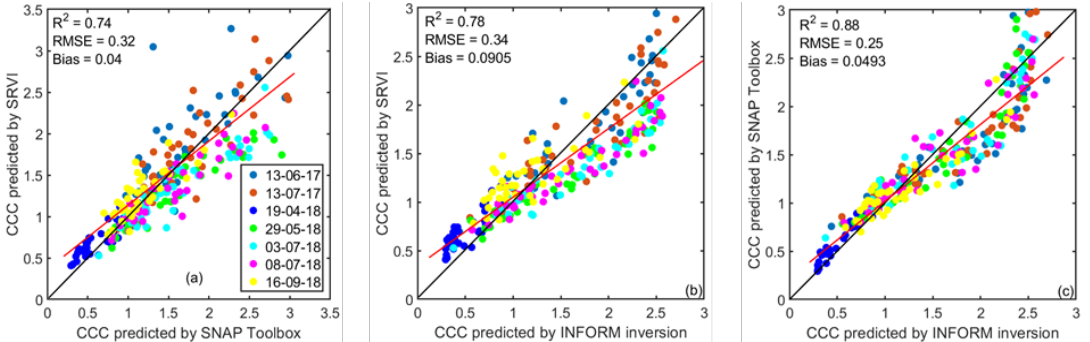
Figure 9. The goodness of fit between CCC values predicted by SRVI vs. SNAP toolbox ( a ), INFORM inversion vs. SRVI ( b ), and INFORM inversion vs. SNAP toolbox ( c ) for seven dates of Sentinel-2 data available for BFNP. The lines in black show the 1:1 relationship, whereas the lines in red, demonstrate the relationship between the CCC estimates by the selected algorithms.